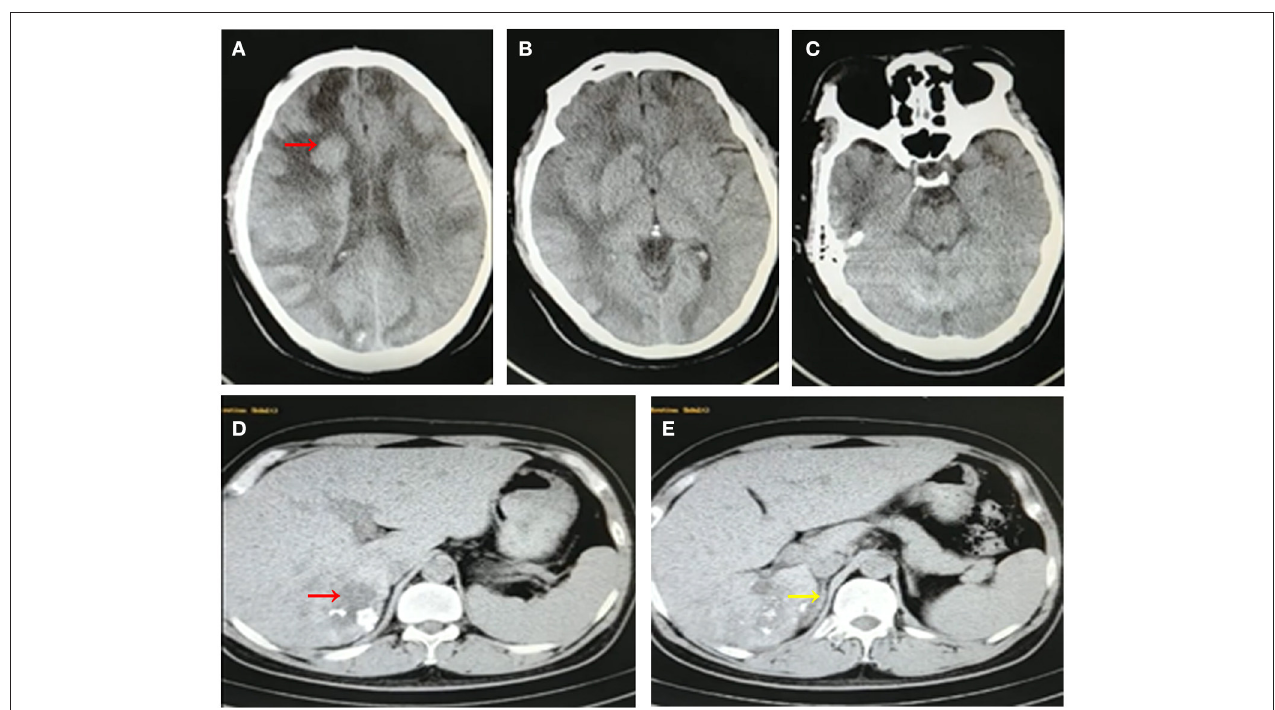
FIGURE 3 | Follow-up CT images of the patient after 1-year albendazole therapy. Brain CT images revealed multiple lesions has slightly shrink and surrounding edema was slightly relieved (A–C) . Abdominal CT images showed that the lesion in liver was obviously diminished accompanied with calcification (D,E)